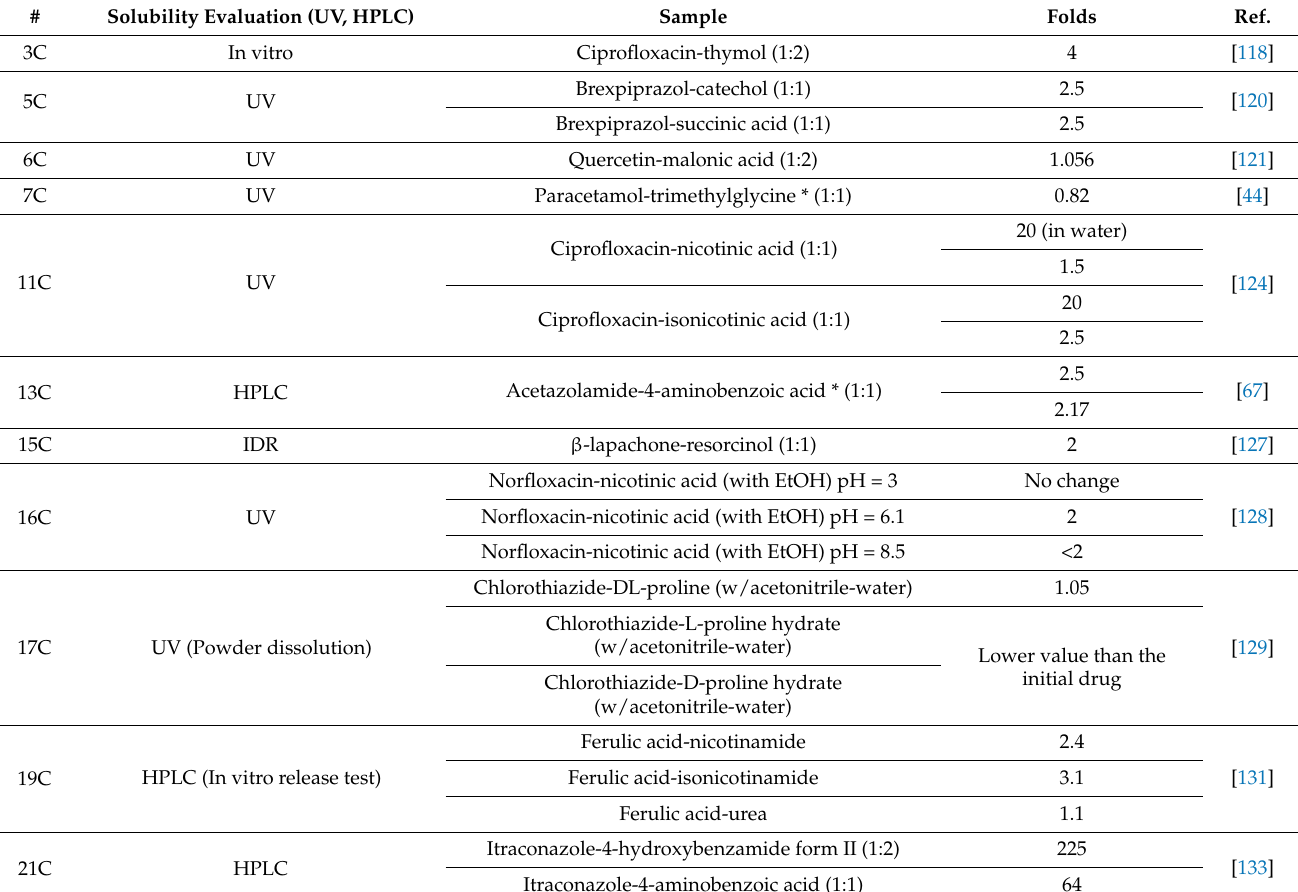
Table 5. Overview of solubility enhancement reported for co-crystal